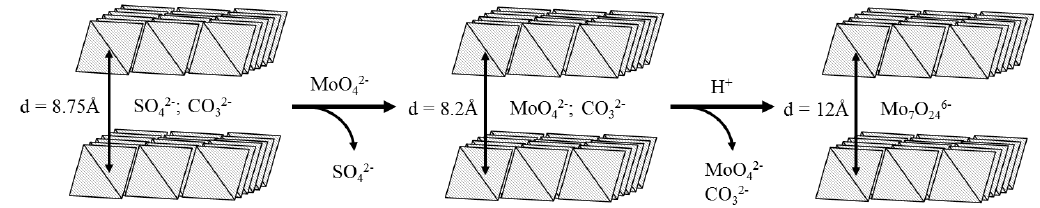
Figure 9. Schematic representation of molybdate exchange in LDH. Adapted from Ref. [60], Copyright 2013, American Chemical Society.